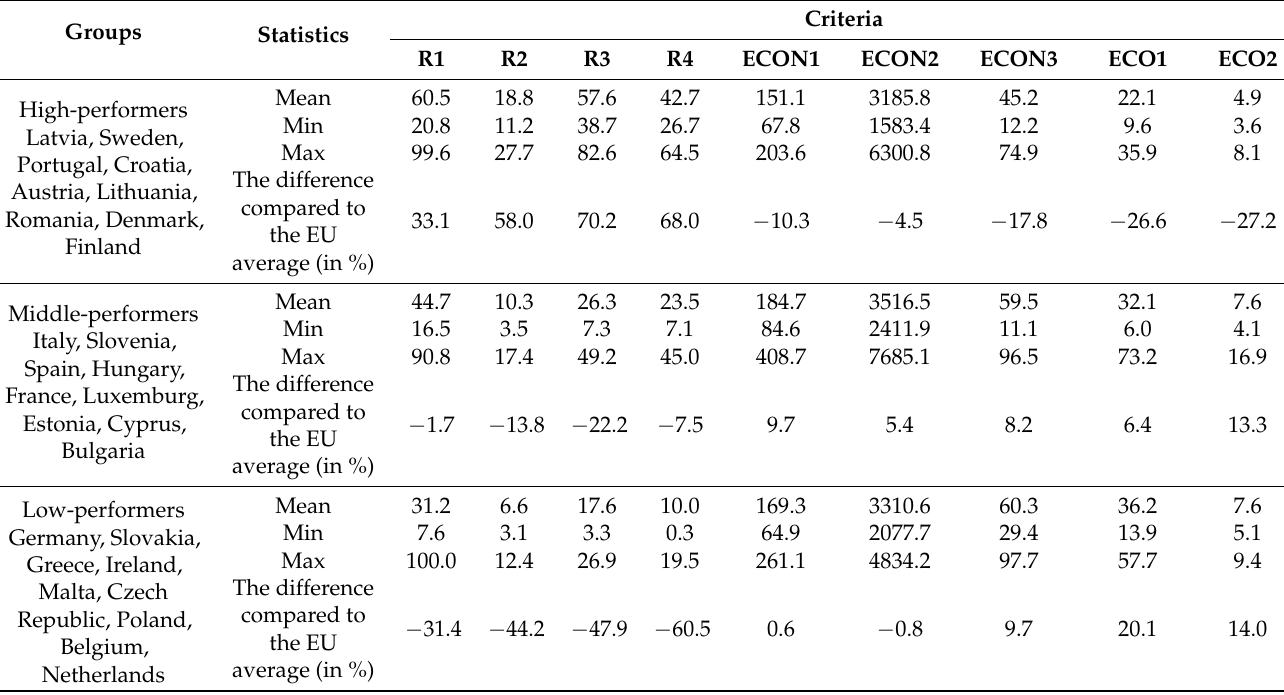
Table 4. The characteristics of derived groups of countries in